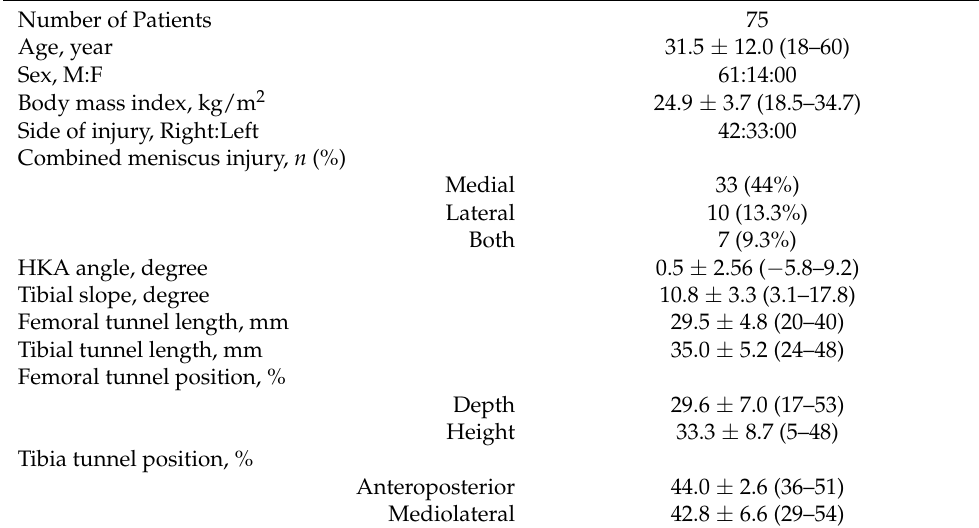
Table 2. Demographic, preoperative, and intraoperative data for enrolled